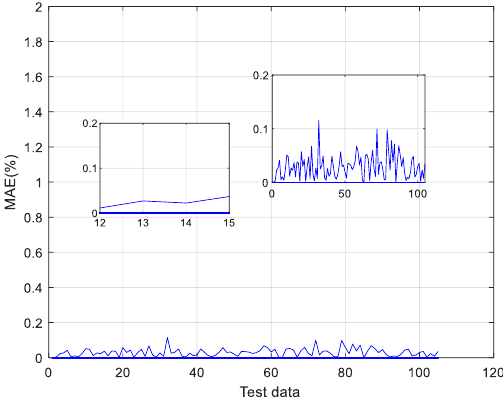
Figure 11. The MAE of SOC estimation.